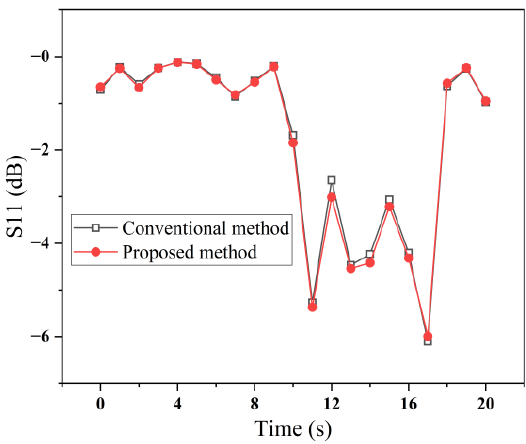
Figure 8. S 11 computed by the proposed method and the conventional method.